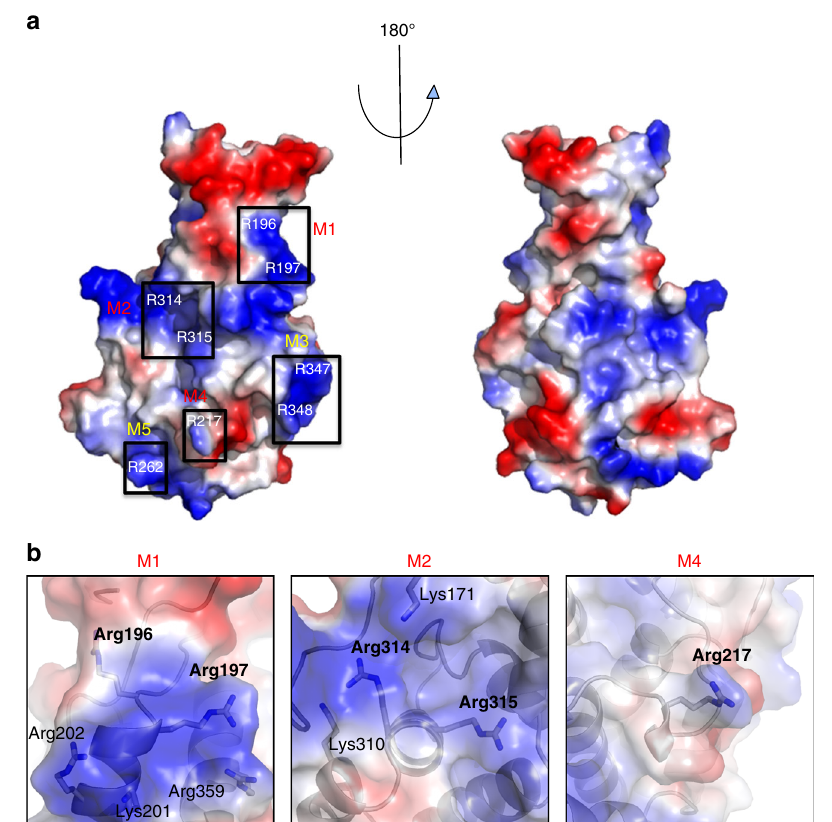
Fig. 3 Charged residues on the surface of DotM. a Electrostatic surface representation of DotM153. Blue and red patches indicate positively and negatively charged surfaces, respectively. Black boxes identify Arg-rich surfaces that were mutated in this study. The boxes are labeled M1-5 according to the nomenclature used to name these mutants (see main text and Table 3), and these labels are colored red for mutants abolishing binding or yellow for mutants that do not affect binding. b Zoom-in into Arg-rich patches contributing to peptide binding. Semi-transparent surfaces are as in A. Residues are in stick representation, color-coded as in Fig. 1c